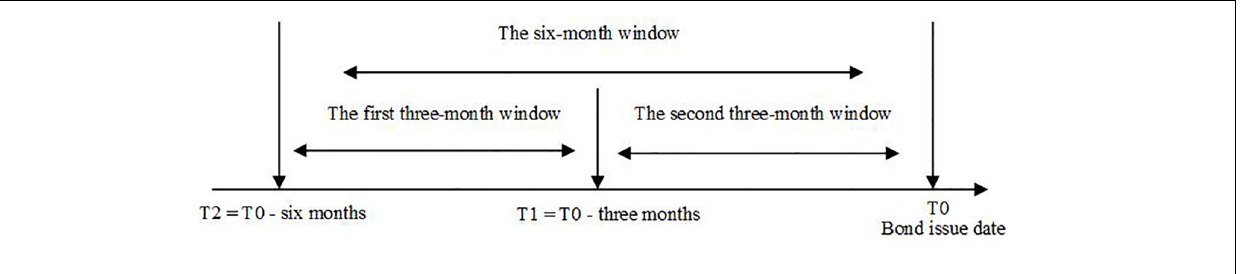
FIGURE 1 | Dividing the 6-month window into two 3-month